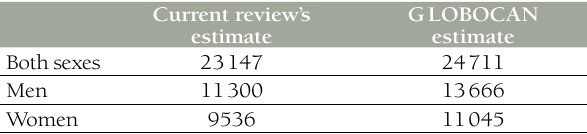
Table 4 Comparison of estimates of annual new cases